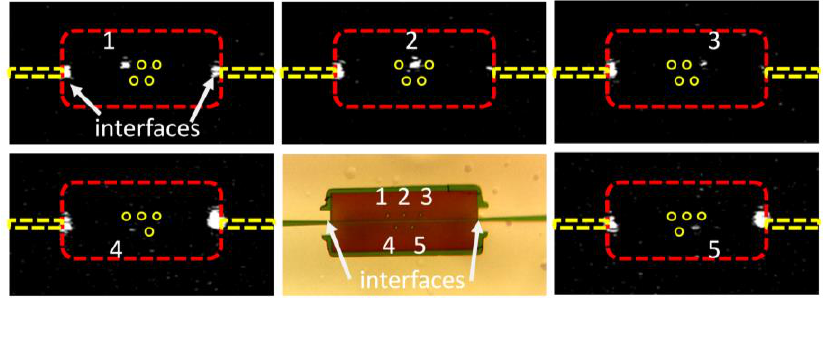
Figure 6. Independent excitation of multiple cavities within the same photonic crystal transferred to